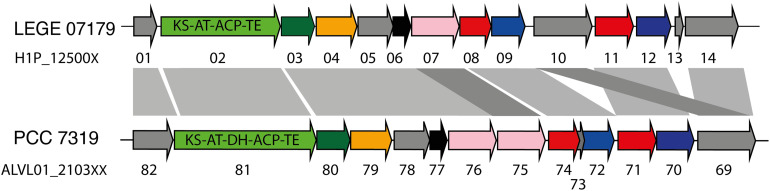
PKS Gene cluster shared by Hyella patelloides LEGE 07179 and Pleurocapsa sp. PCC 7319. The genes are color coded according to their putative function: green for PKS (with the domains listed), dark green for 3-oxoacyl synthase, orange for cytochrome P450, pink for NAD(P)-binding domain-containing protein, blue for sulfotransferase, red for transporter, black for methyltransferase and gray for unknown proteins. KS, ketosynthase; AT, acyltransferase; ACP, acyl carrier protein; TE, thioesterase; DH, dehydratase. Further details provided in Supplementary Table S13.